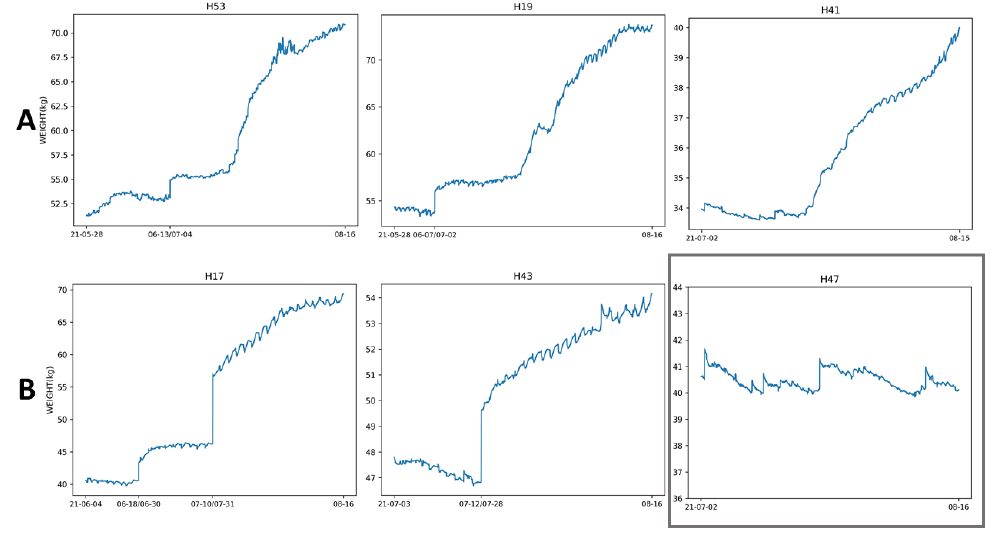
Figure 4. Weight (kg) vs. time of hives H17, H19, H41, H43, H47, and H53; first (leftmost) and last (rightmost) x-labels depict first and last day of time-aligned weights and video records; additional marks on x-axis in between leftmost and rightmost labels denote periods when videos were not taken due to hardware failures (e.g., 13 June/4 July on x-axis of H53 plot means that in H53 videos were not taken from 13 June 2021 up to 4 July 2021); row ( A ): weight vs. time for hives with positive correlation coefficients; row ( B ): weight vs. time with negative correlation coefficients; in row ( B ) weight vs. time plot of H47 is in gray box; H47 is the only hive for which H ρ ,0 and H χ 2 ,0 were not